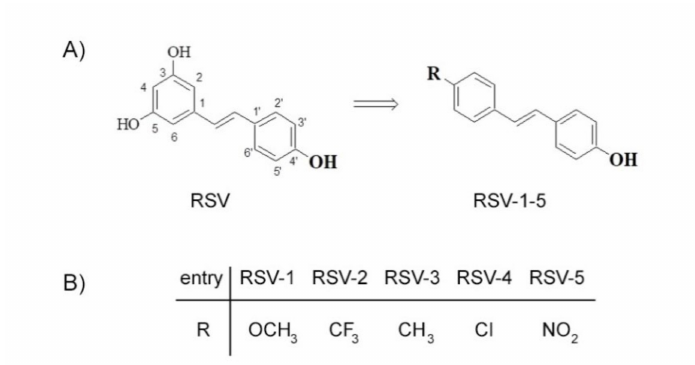
Figure 1. Resveratrol (RSV) ( A ) and its derivatives RSV-1–5 ( B